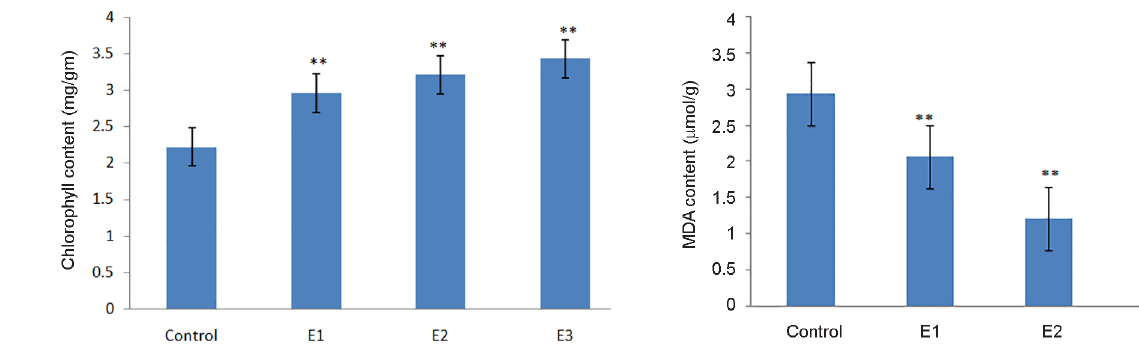
Figure 3. Change in Chlorophyll content in the experimental plants